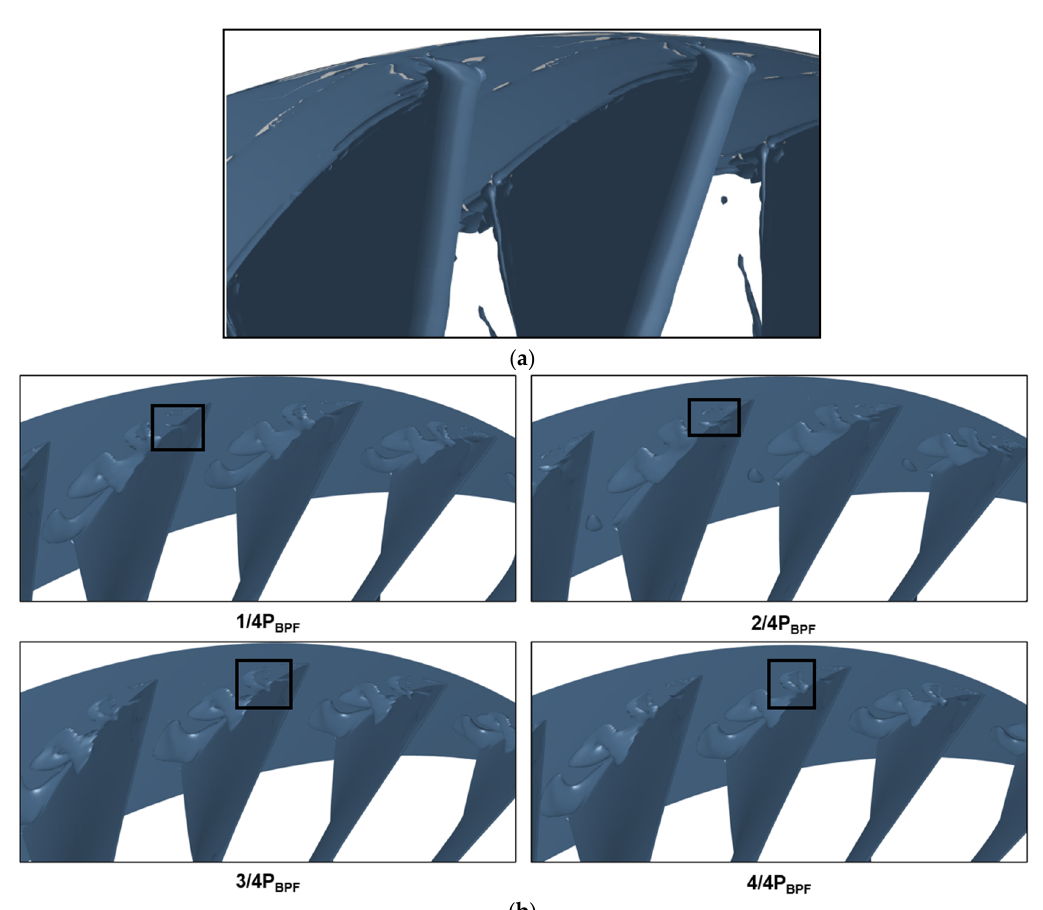
Figure 11. Iso-surfaces of instantaneous vorticity at λ = 0.25. ( a ): Peak efficiency (PE), steady results. ( b ): Near-stall (NS), transient result, P BPF is the period of the blade passing.